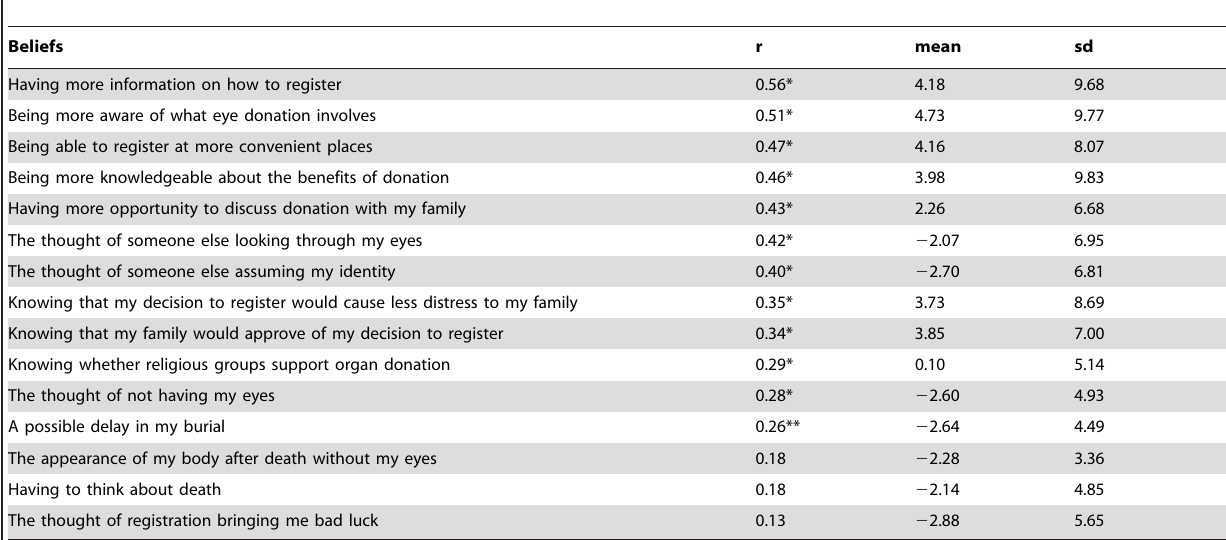
Table 5. Means and standard deviations of control beliefs and Pearson’s correlations (r) of control beliefs with intention.